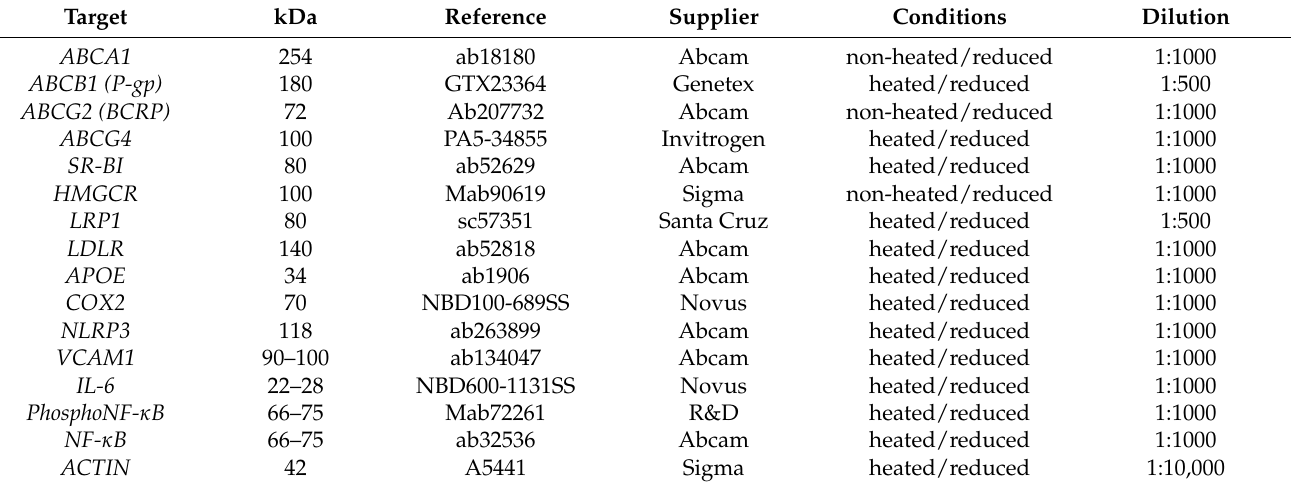
Table 2. Western blot antibody details. Summary of primary antibodies used for Western